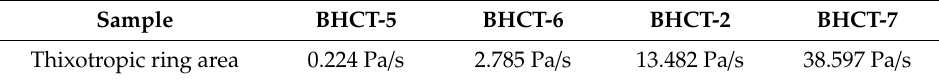
Figure 9. Shear thixotropy of composite gels at different bentonite concentrations. Table 3. Thixotropic ring area of composite gels of different bentonite concentrations.